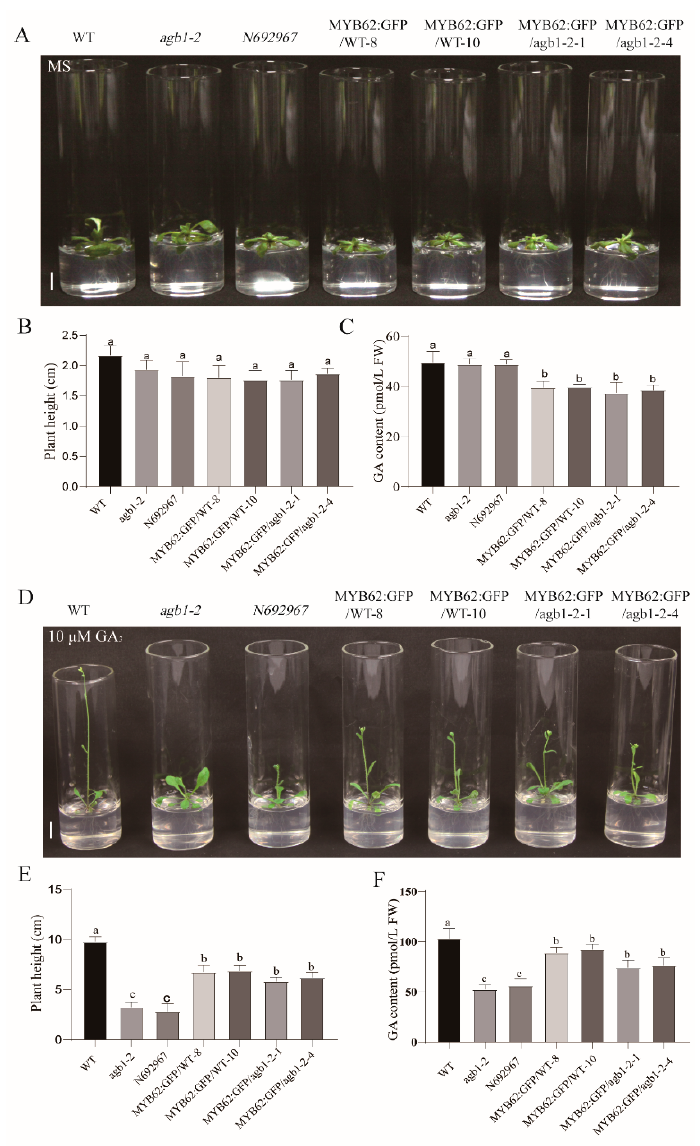
Figure 4. Phenotypic identification of the wild-type, agb-1-2 , N692967 , MYB62 :GFP/WT-8, MYB62 :GFP/WT-10, MYB6 2:GFP/ agb1-2 - 1 , and MYB62 :GFP/ agb1-2 - 4 under normal conditions and 10 µ M GA 3 treatment. ( A ) Plant height phenotype of the wild-type (Col-0), agb-1-2 , N692967 , MYB62 :GFP/WT-8, MYB62 :GFP/WT-10, MYB62 :GFP/ agb1-2-1 , and MYB62 :GFP/ agb1-2-4 under nor- mal conditions. Scale bars, 1 cm. ( B , C ) Plant height and GA content of the wild-type (Col-0), agb-1-2 , N692967 , MYB62 :GFP/WT-8, MYB62 :GFP/WT-10, MYB62 :GFP/ agb1-2-1 , and MYB62 :GFP/ agb1-2-4 under normal conditions. The data are the average of three independent experiments, and the er- ror bar represents the SE ( n = 10). a, b indicate significant differences. Significant differences were analyzed using Duncan’s multiple range test ( p < 0.05). ( D ) Plant height phenotype of the wild- type (Col-0), agb-1-2 , N692967 , MYB62 :GFP/WT-8, MYB62 :GFP/WT-10, MYB62 :GFP/ agb1-2-1 , and MYB62 :GFP/ agb1-2-4 under 10 µ M GA 3 treatment. Scale bars, 1 cm. ( E , F ) Plant height and GA content of the wild-type (Col-0), agb-1-2 , N692967 , MYB62 :GFP/WT-8, MYB62 :GFP/WT-10, MYB62 :GFP/ agb1-2-1 , and MYB62 :GFP/ agb1-2-4 under 10 µ M GA 3 treatment. The data are the average of three independent experiments, and the error bar represents the SE ( n = 10). a, b c indicate significant differences. Significant differences were analyzed using Duncan’s multiple range test ( p <